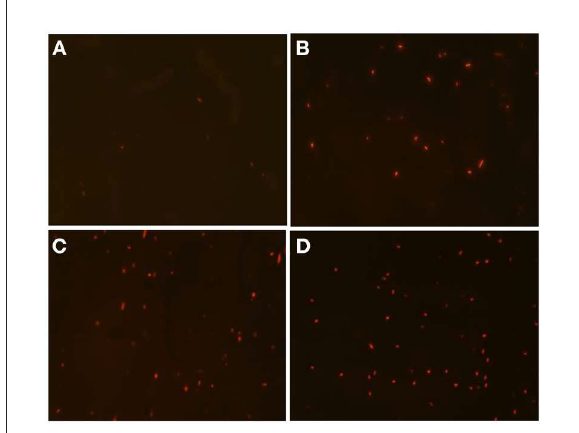
FIGURE2 The PI staining A. acidoterrestris cells treated by DBD-plasma at 30 kV for 0 (A) , 0.5min (B) , 1.0min (C), and 2.0min (D) ,